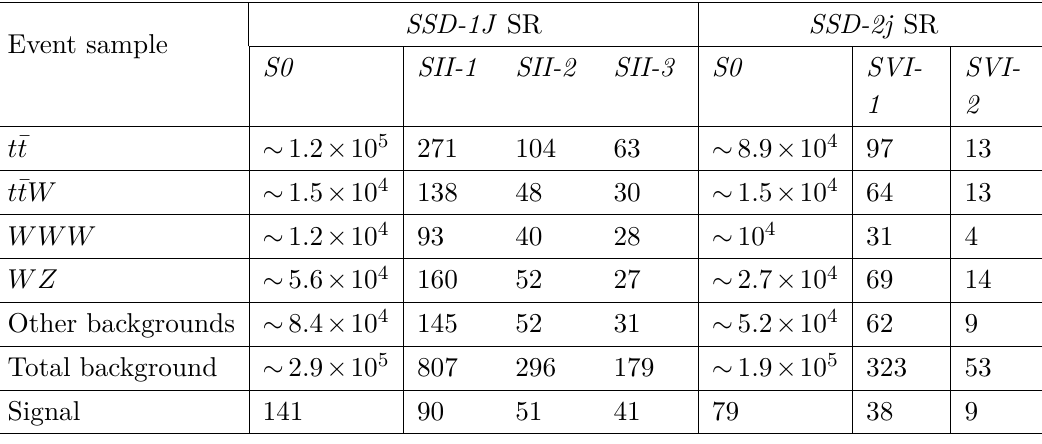
Table 7 . The numbers of expected background and signal events in SSD-1J and SSD-2j SRs after passing various selection cuts for BP1 in Model- 3 F LHC.